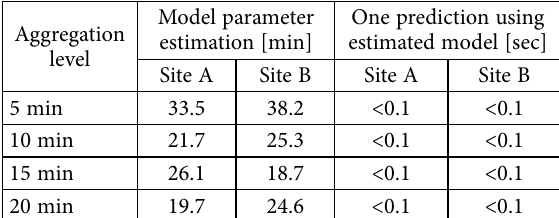
Fig. 11. Prediction results for different aggregation time intervals by using the hybrid method at Site B Table 10. Prediction accuracy comparison Table 11 gives the Central Processing Unit (CPU) times needed for the estimation of the hybrid model MRE of the parameters, and the CPU times needed for the applica- Authors proposed model ing a desktop computer (3.4 GHz CPU and 8GB RAM). Table 11. The CPU times for model calibrations and